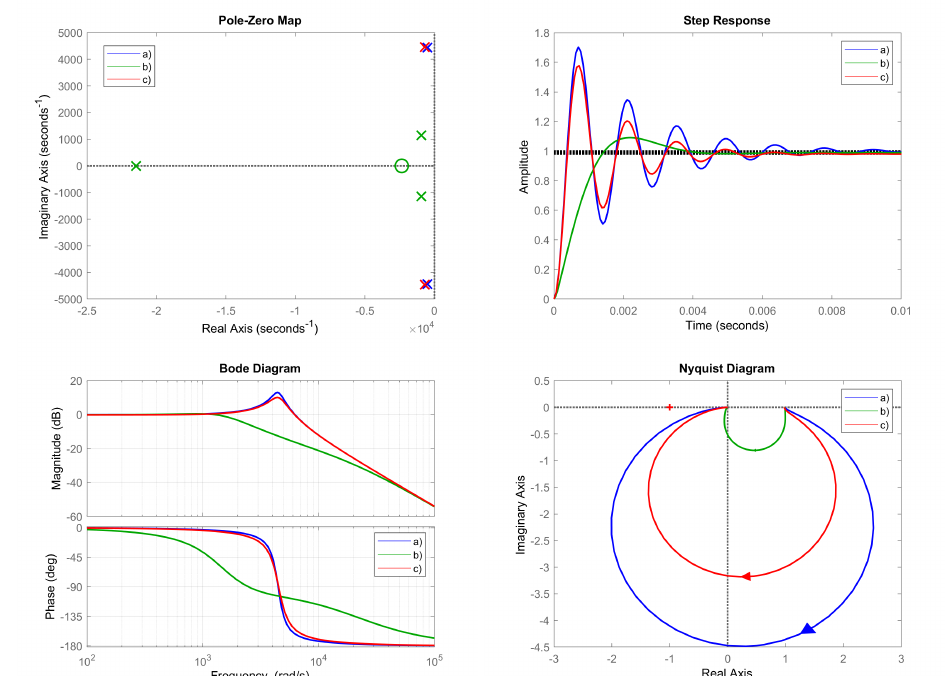
Figure 11. Poles and zero, step responses, Bode and Nyquist plots of the open loop system in two modes. (a) no-load, (b) RC load, (c) resistive load R L = 50 Ω . Notice small differences between characteristics of the no-load and the resistive load system, and a large discrepancy between the no-load and RC load system.